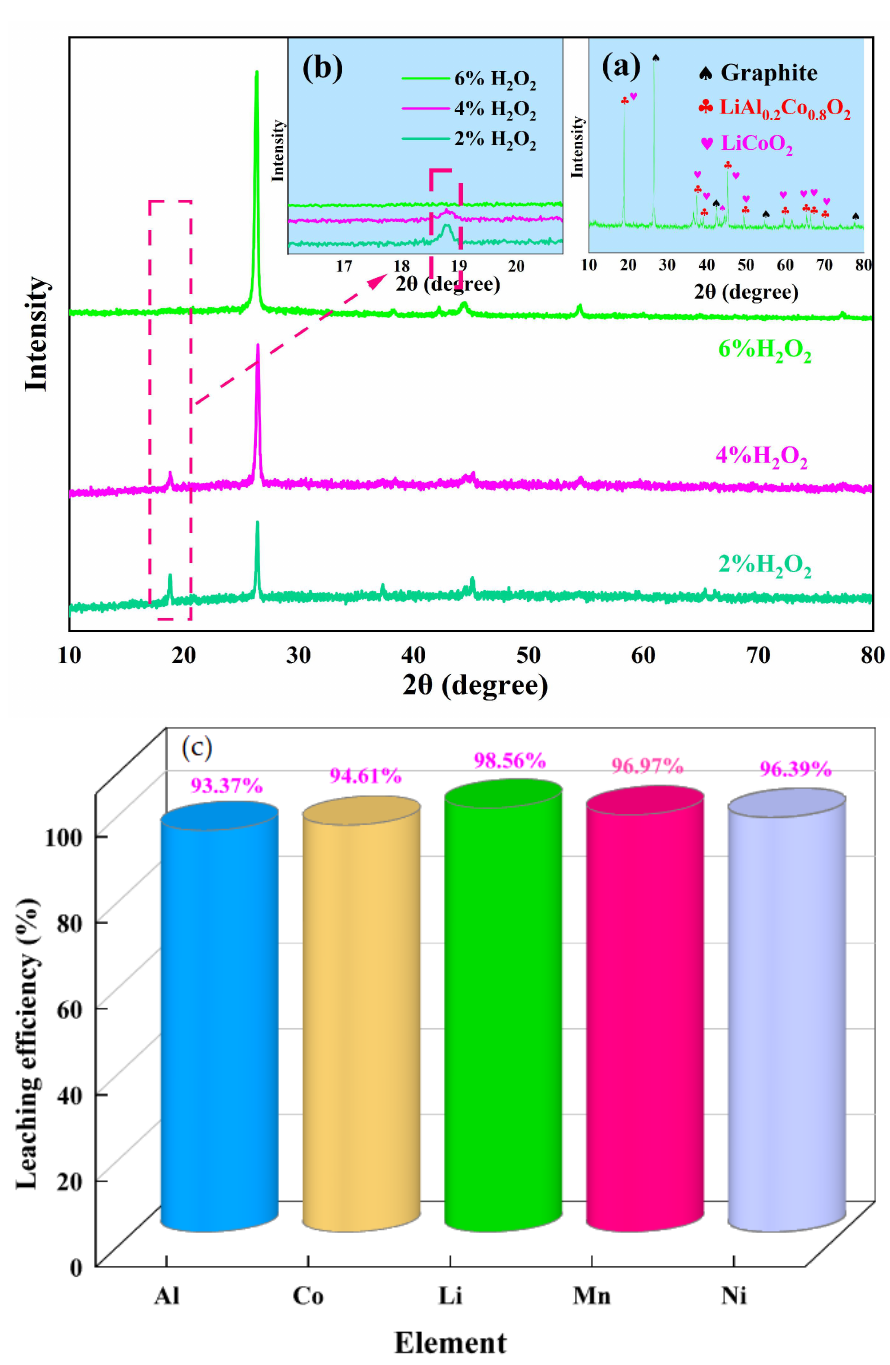
Figure 6. XRD patterns of leaching residues with different H 2 O 2 concentrations. ( a ) XRD patterns of powder before leaching. ( b ) Enlarged image of the strongest spectral peak for LiCoO 2 and LiAl 0.2 Co 0.8 O 2 . ( c ) Leaching rates for metal elements. SEM analysis: Figure 7a–d show scanning electron micrographs (SEMs) of the elec-